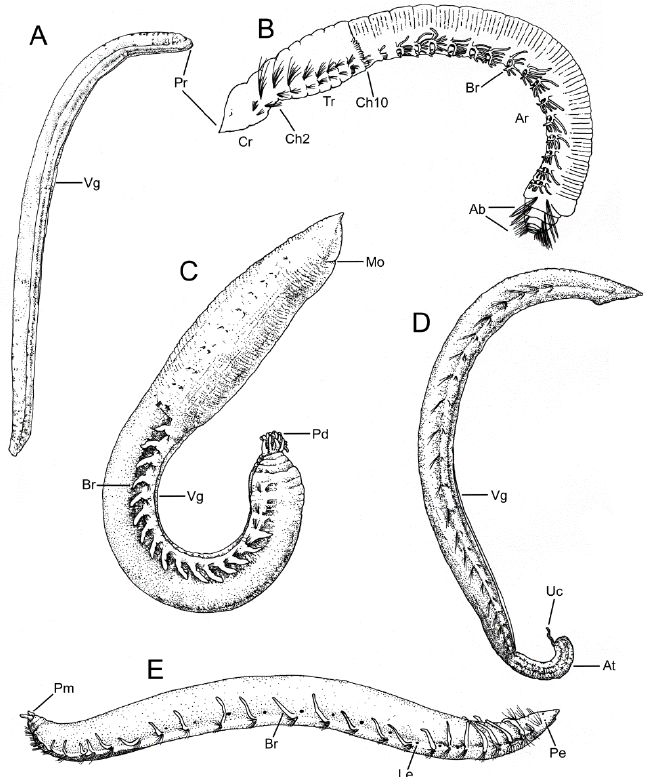
Figure 1. Stylized drawings of opheliids of the subfamily Opheliinae ( B , C ) and Ophelininae ( A , D , E ). ( A ) Polyophthalmus pictus in latero-ventral view; ( B ) Thoracophelia japonica in lateral view (chaetiger numbers mark limit between body regions); ( C ) Ophelia bicornis in lateral view; ( D ) Ophelina abranchi- ata in lateral view; ( E ) Armandia cirrhosa in lateral view. ( A , C – E ) redrawn after Parapar [4]; ( B ) modified after Misaka and Sato [22]. Abbreviations: Ab—abranchiate chaetigers; Ar—abdominal re- gion; At—anal tube; Br—branchia; Ch—chaetiger; Cr—cephalic region; Le—lateral eye; Mo—mouth; Pd—pygidium dorsal papillae; Pe—prostomial subdermal eye; Pm—pygidium marginal papillae; Pr—prostomium; Tr—thoracic region; Uc—unpaired anal cirrus; Vg—ventral